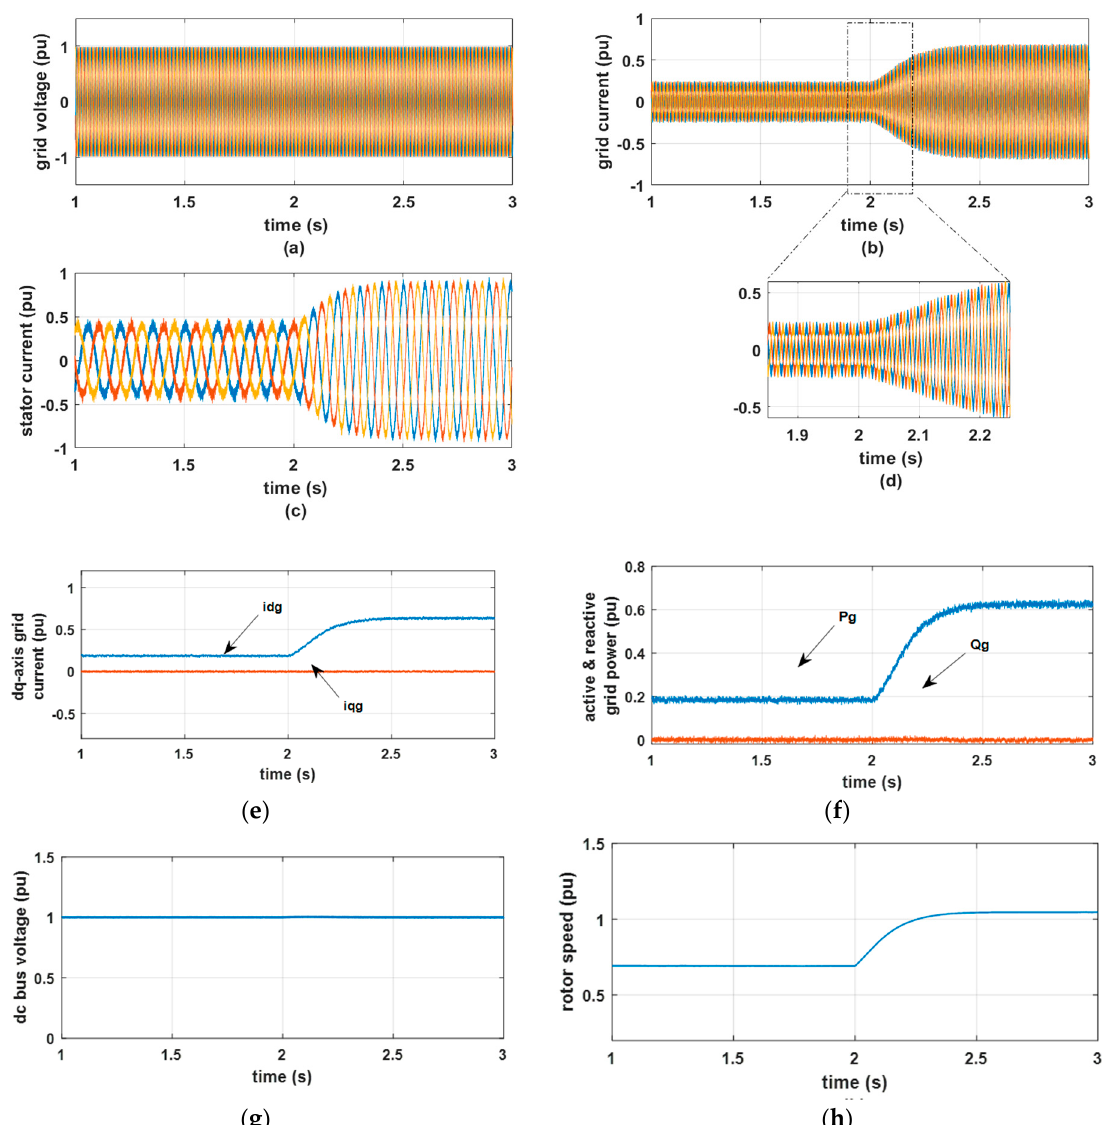
Figure 11. Simulation results of proposed scheme under step change of wind speed: ( a ) grid voltage; ( b )grid current; ( c ) stator current; ( d ) Zoom of grid current; ( e ) dq-axis of grid current; ( f ) active and reactive grid power; ( g ) dc bus voltage; ( h ) rotor speed.